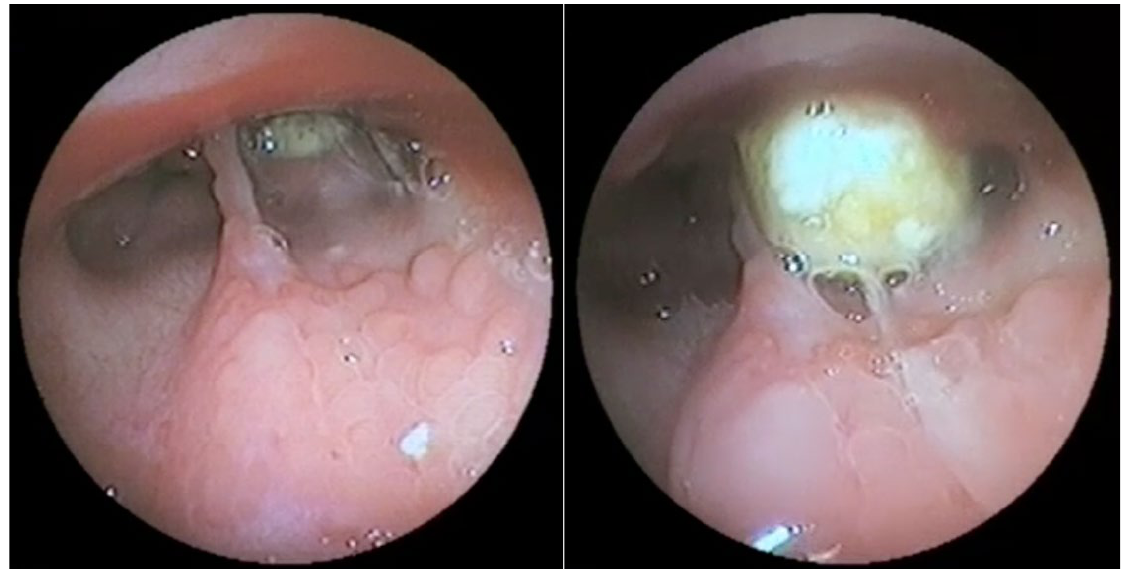
Figure 3. Endoscopic features of the nasopharynx of a dog with reverse sneezing showing the pres- ence of a foreign body lodged in the right choana before ( left ) and after ( right ) its partial mobiliza- tion by flushing. Note the presence of follicular inflammation of the surrounding mucosa. In this case, the foreign body (dry chickpea) was removed by pushing it with the help of forceps introduced through the nostril, which resolved the reverse